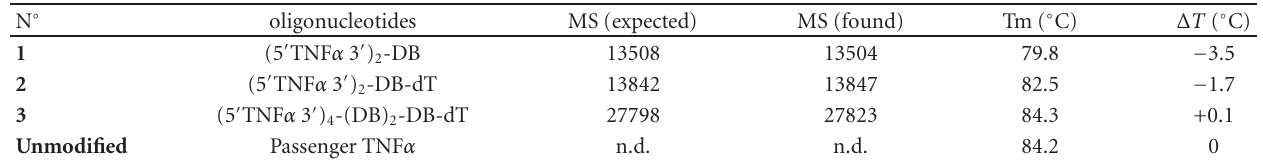
Table 1: Mass spectrometry data on modified passenger strand and melting temperatures of siRNA duplexes formed by oligonucleotides 1 , 2 , and 3 and the linear unmodified control sequences. Bu ff er conditions: 15mM HEPES, 1 mM magnesium acetate, 50mM potassium acetate pH